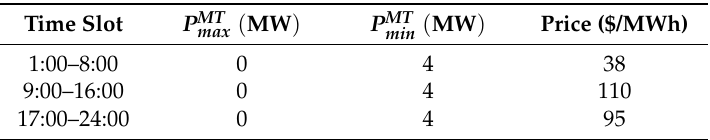
Figure 5. ( a ) Switching index of each remotely controlled switch (RCS), ( b ) Daily maximum allowable switching actions. Table 1. The details of bilateral contracts between Micro Turbine (MT) owners and Distribution System Operator (DSO).